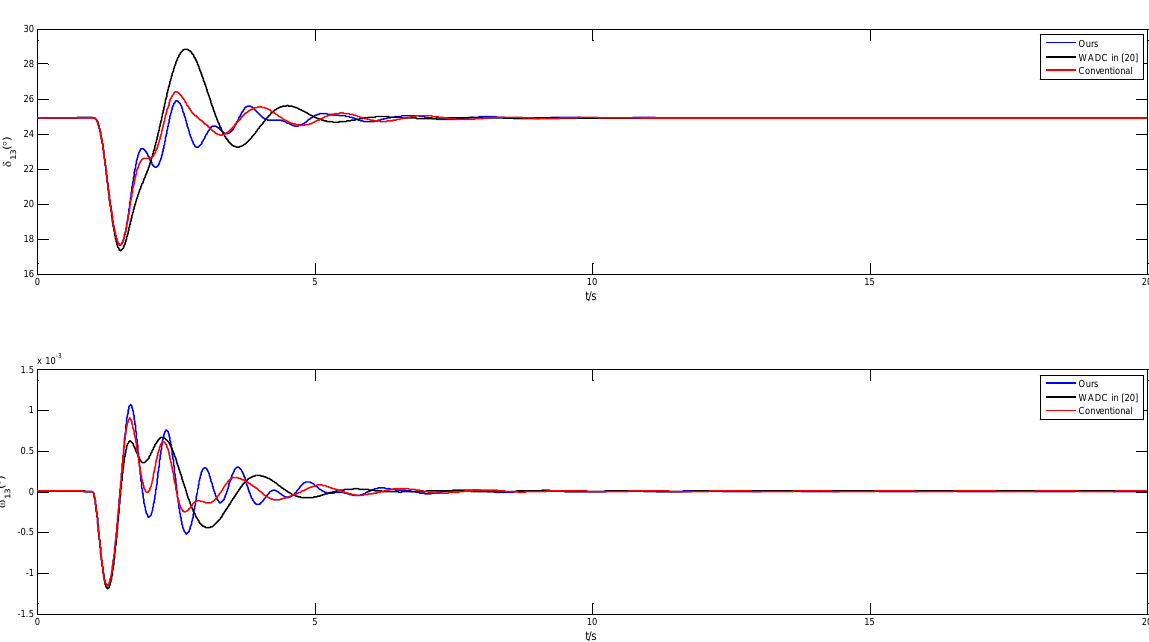
Figure 9. Response of the system in Scenario 2 when 𝜌 = 0 .3.